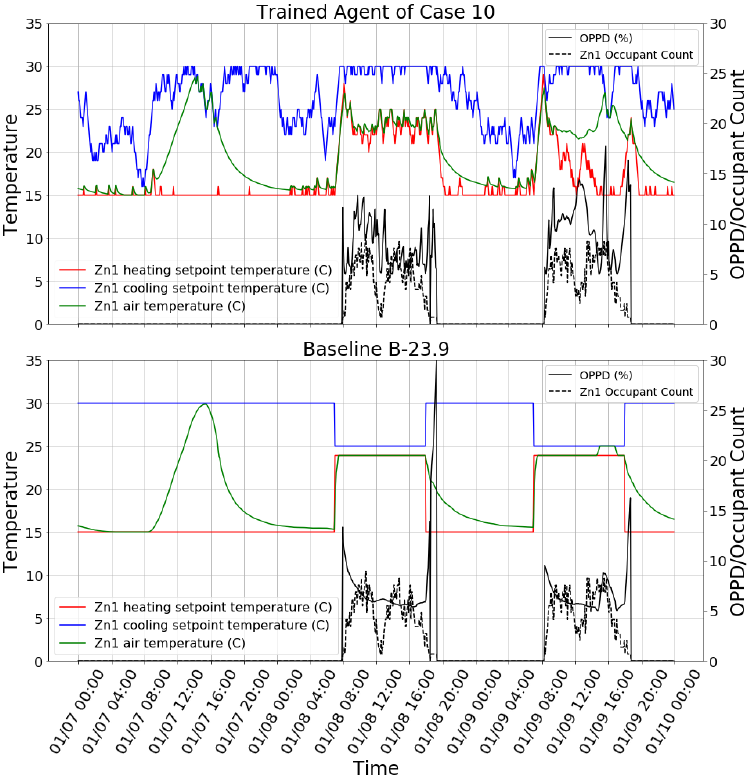
Figure 7. Single-zone testing in the testing building model: control behavior snapshot of the trained agent of case 10 ( top ) and the baseline case B-23.9 ( below ).